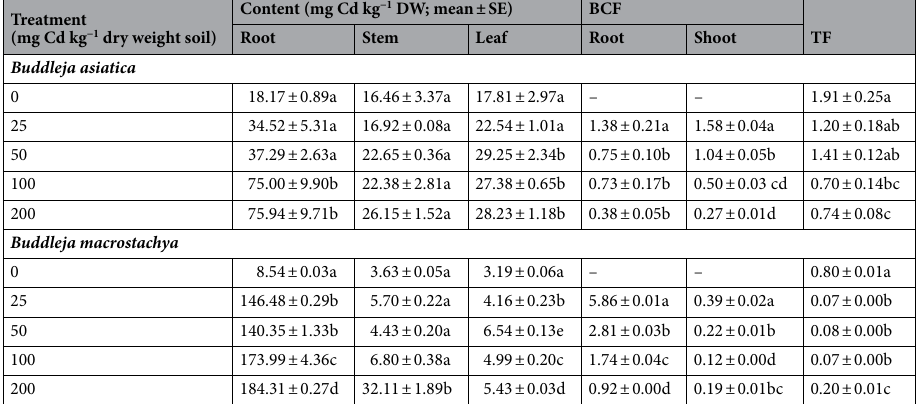
Table 1. Characteristics of cadmium uptake, transfer, and accumulation (mean ± S.E.; n = 3) of B. asiatica and B. macrostachya under different Cd treatments. Different letters indicate different significant differences (One- way ANOVA; p <